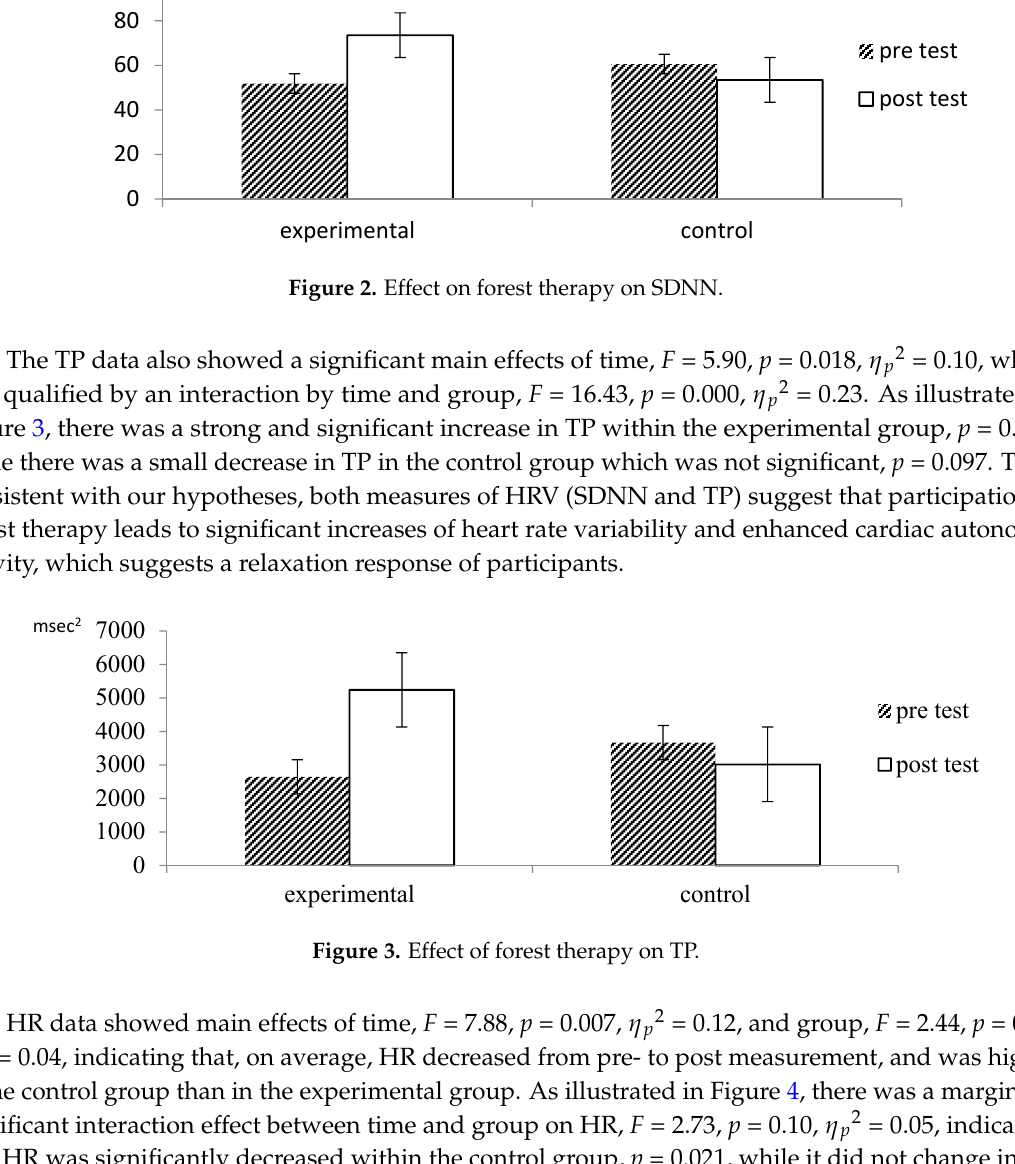
Figure 4. Effect on forest therapy on HR.